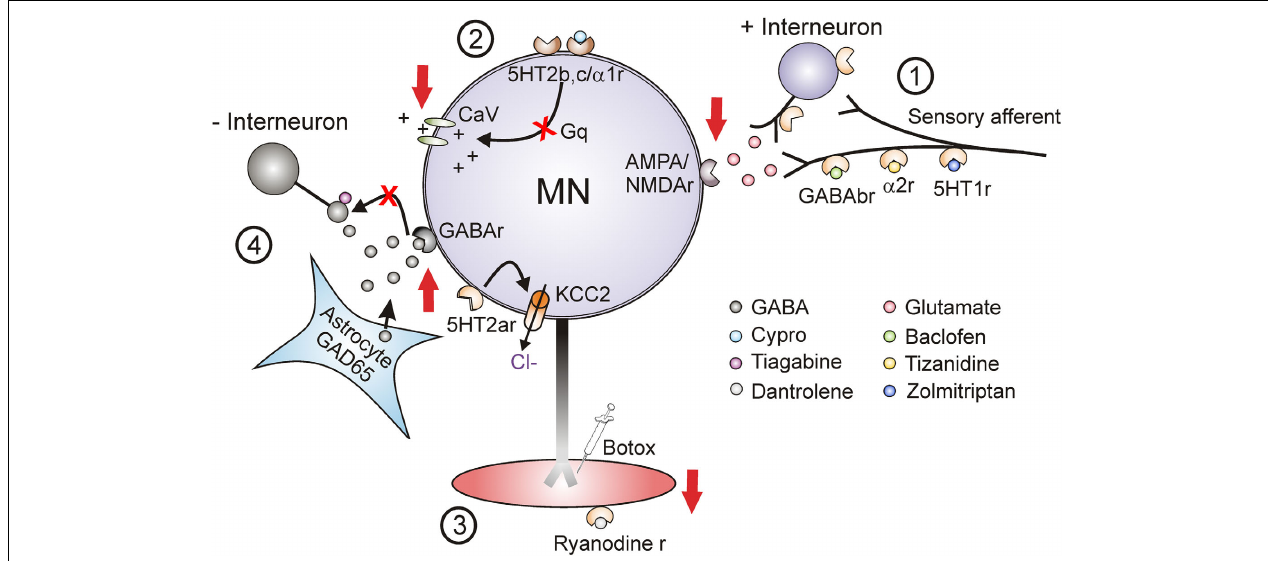
reducing activity in the Gq pathway and lessening activation of PICs and consequently muscle spasms. Site 3: Botulinum toxin (Botox ® ) injection directly into spastic muscles or activation of ryanodine receptors by dantrolene sodium (dantrolene) reduces spasticity by targeting the muscle site directly. Site 4: Spinal injection of the HIV1-CMV-GAD65 lentivirus increases GAD65 gene expression and GABA release from astrocytes. Systemic administration of tiagabine, a GABA reuptake inhibitor, increases amount of enhanced GABA in synapse to activate pre- and post-synaptic GABA receptors to reduce motoneuron excitability. Activation of 5-HT 2A receptors increases cell expression of KCC2 cotransporter to reduce intracellular concentration of Cl − and increase endogenous motoneuron inhibition. Adapted from D’Amico et al.